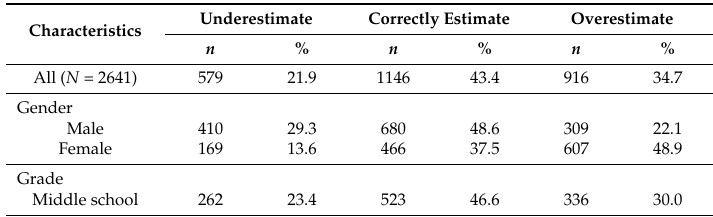
Table 3. Proportions of weight status misperception ( N =